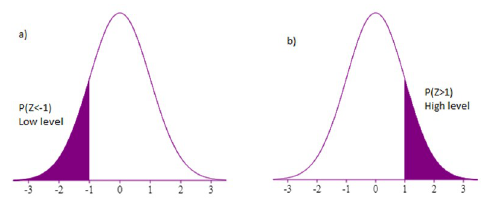
Figure 2. Low ( a ) and high ( b ) levels in AMT implementation.